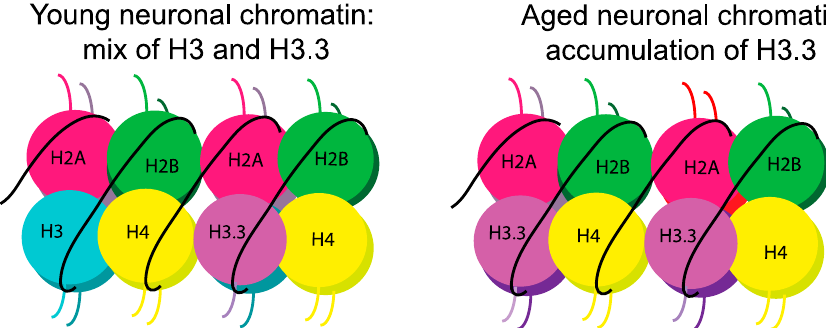
Figure 3. Histone variant H3.3 accumulates during aging. H3.3 is present at low levels in young neuronal chromatin, in which total H3 is represented by a mix of H3.3 and canonical H3 ( left ). During aging, H3.3 levels increase, and the variant becomes the predominant H3 histone in chromatin ( right